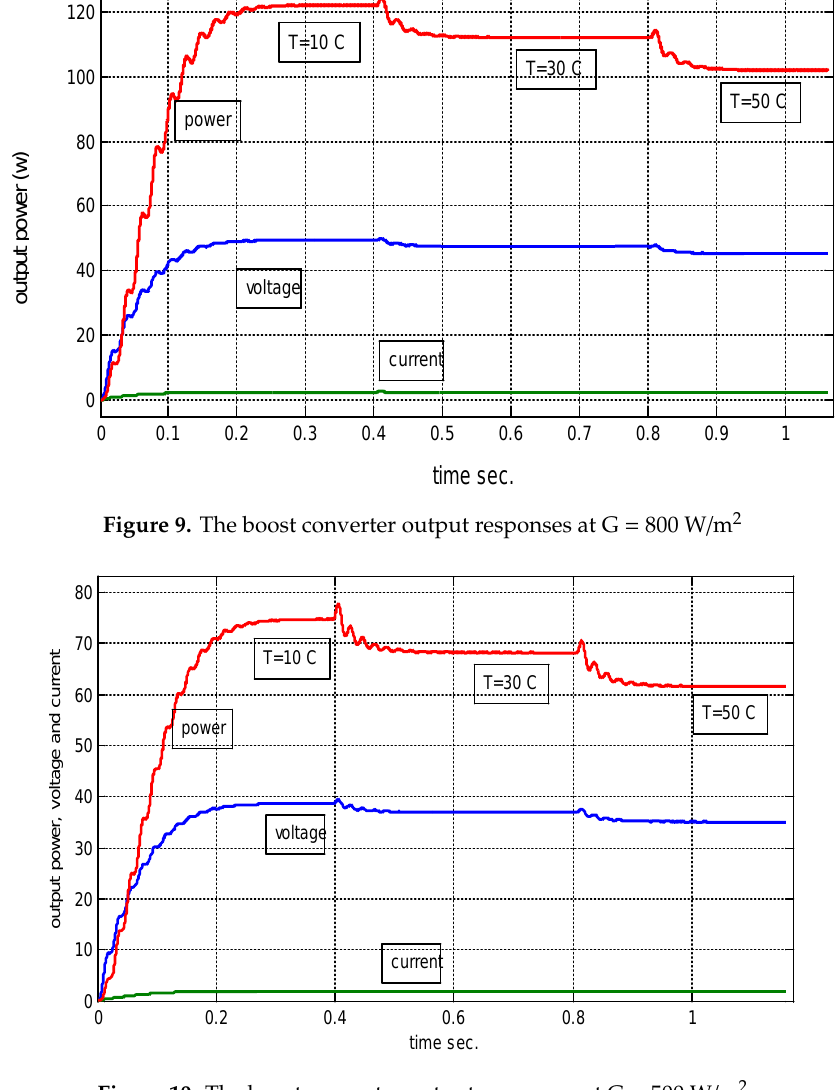
Figure 10. The boost converter output responses at G = 500 W / m 2